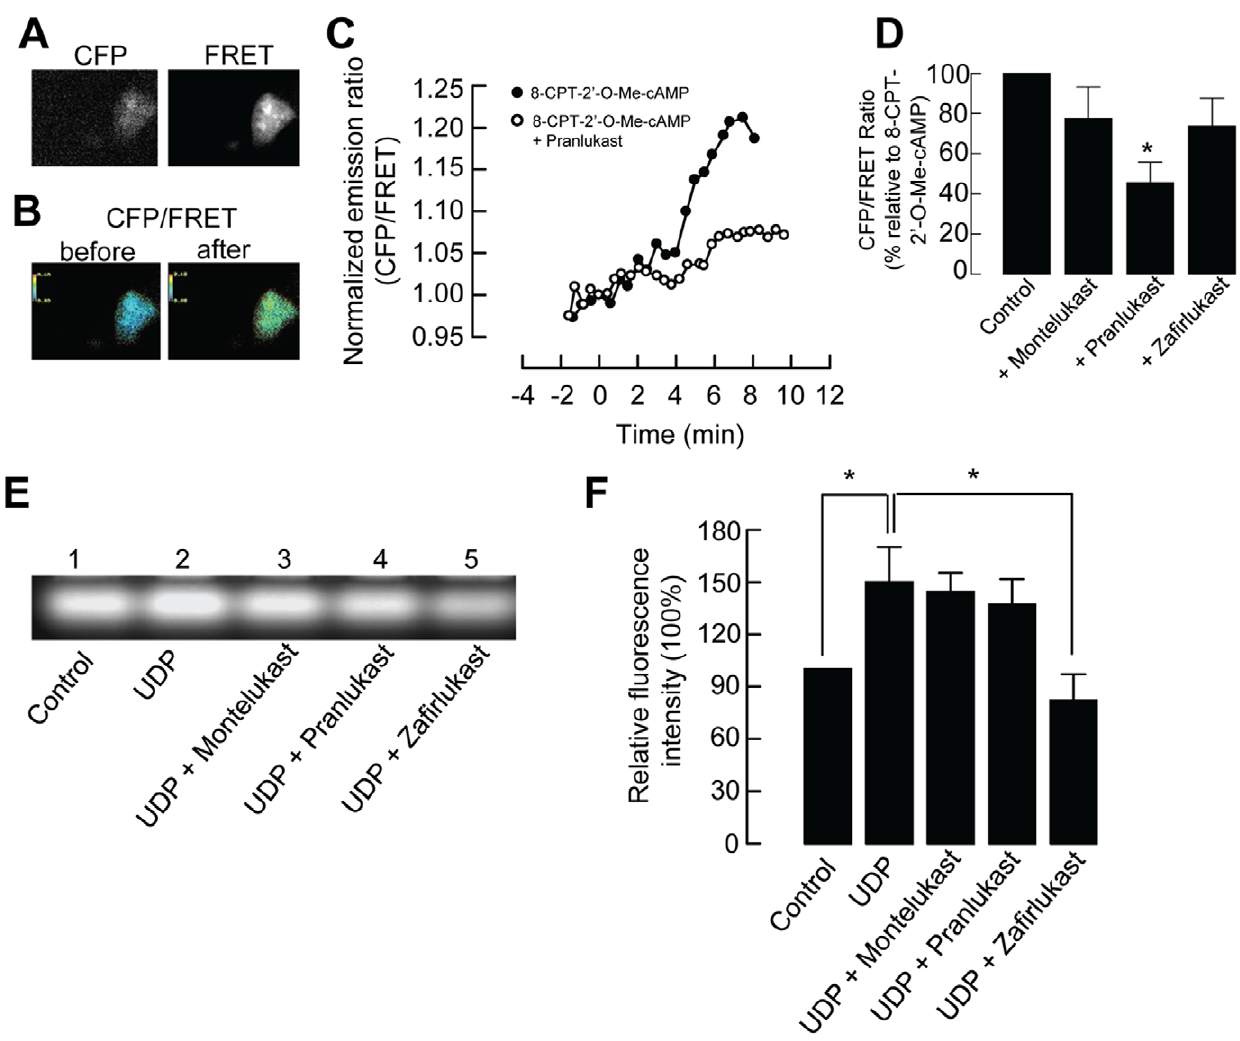
Figure 6. Effects of CysLT 1 receptor antagonists on Epac activation and PKA activity. (A) The monochrome CFP and FRET images showing the cytosolic distribution of the fluorescent Epac probe in 16HBE14o- cells transfected with CFP-Epac-YFP. (B) Representative pseudocolor images of CFP/FRET emission ratios before and after the addition of 8-CPT-2 9 - O -Me-cAMP. (D) Real-time cAMP changes (normalized CFP/FRET emission ratio) recorded in cells stimulated with 50 m M 8-CPT-2 9 - O -Me-cAMP with or without 1 m M pranlukast shown in (B). The agents were added at time zero. (C) Summarized data showing the effect of CysLT 1 receptor antagonists on the CFP/FRET emission ratio. Each column represents the mean 6 S.E. ( n =8– 10). (*, p , 0.05, Student’s t -test compared with control). (E) Confluent 16HBE14o- cells were treated with either vehicle alone (control), 100 m M UDP, or UDP with different CysLT 1 receptor antagonists (1 m M) for 5 min. PKA activity was measured as a function of fluorescence intensity. (F) Summarized data showing the relative fluorescence level as compared with the control level. Each column represents the mean 6 S.E. (*, p , 0.05, n =4, one-way ANOVA with Bonferroni post-hoc test).